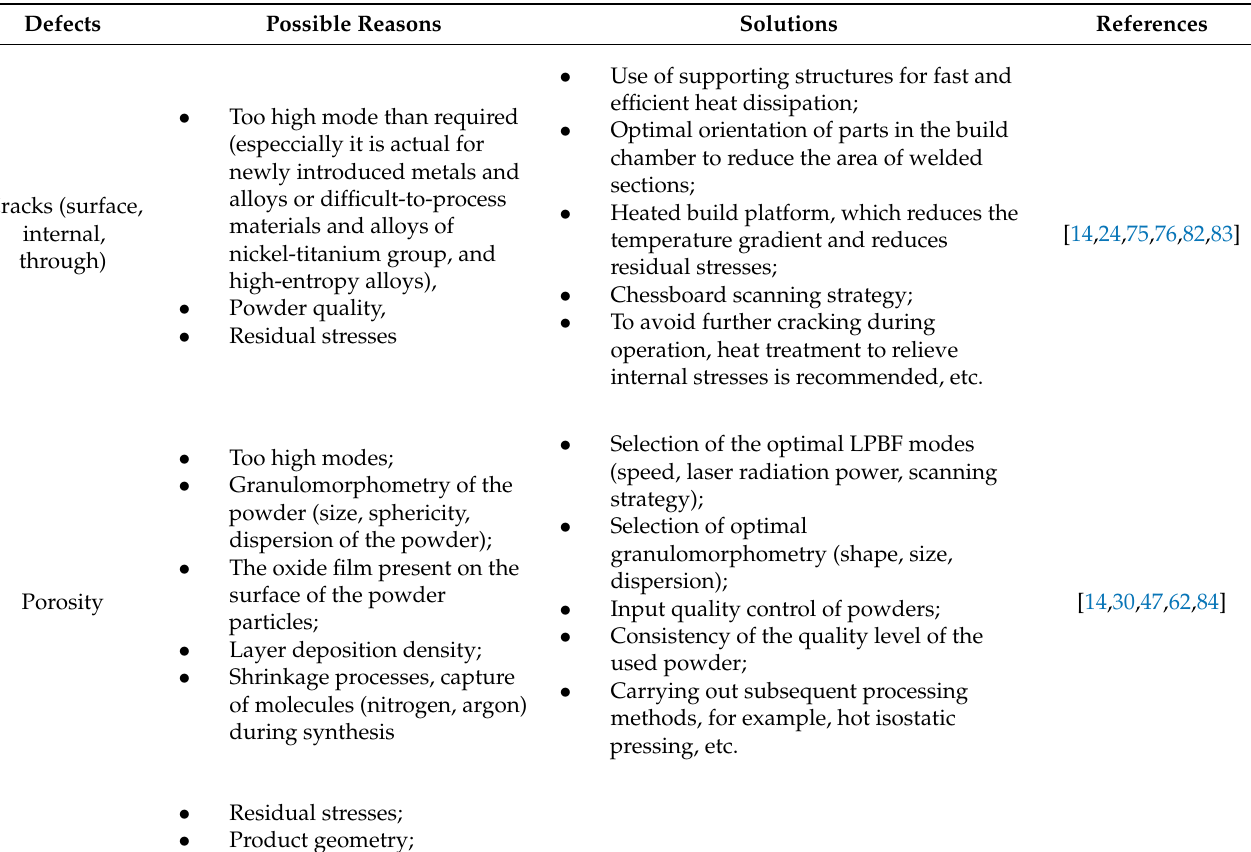
Table 2. Defects in laser powder bed fusion. Defects